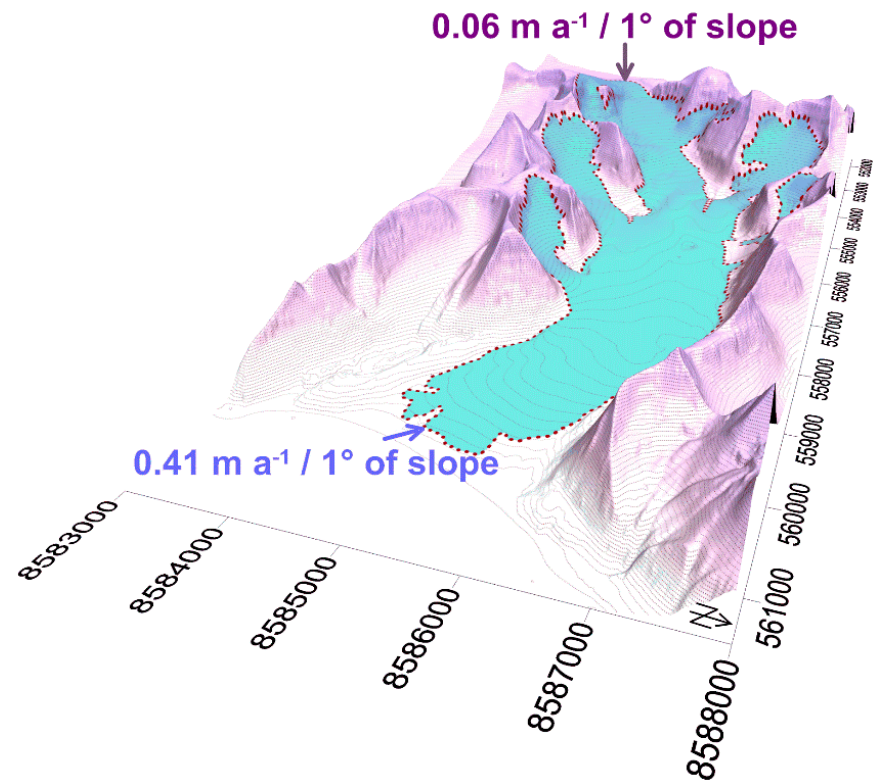
Figure 9. Model of the average rate of deglaciation for Spitsbergen in the vertical profile converted to degrees of terrain slope (source of the Anna Margrethebreen DEM: [35]).